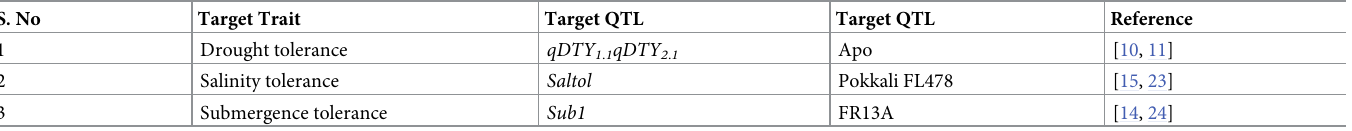
Table 1. Details on Target QTLs, traits and their respective donors.